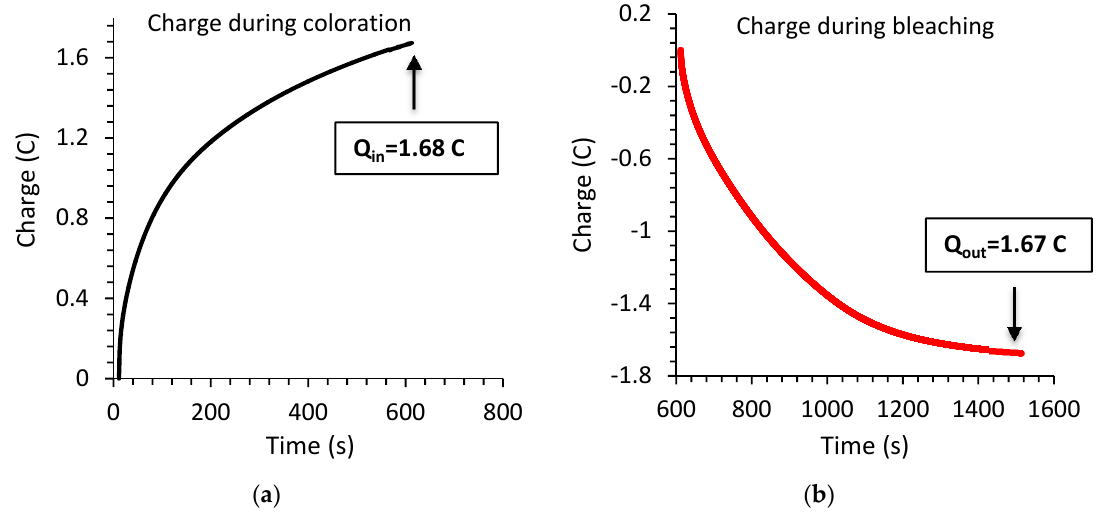
Figure 11. Variation of charge (a) inserted into the electrochromic device and (b) extracted from the electrochromic device.